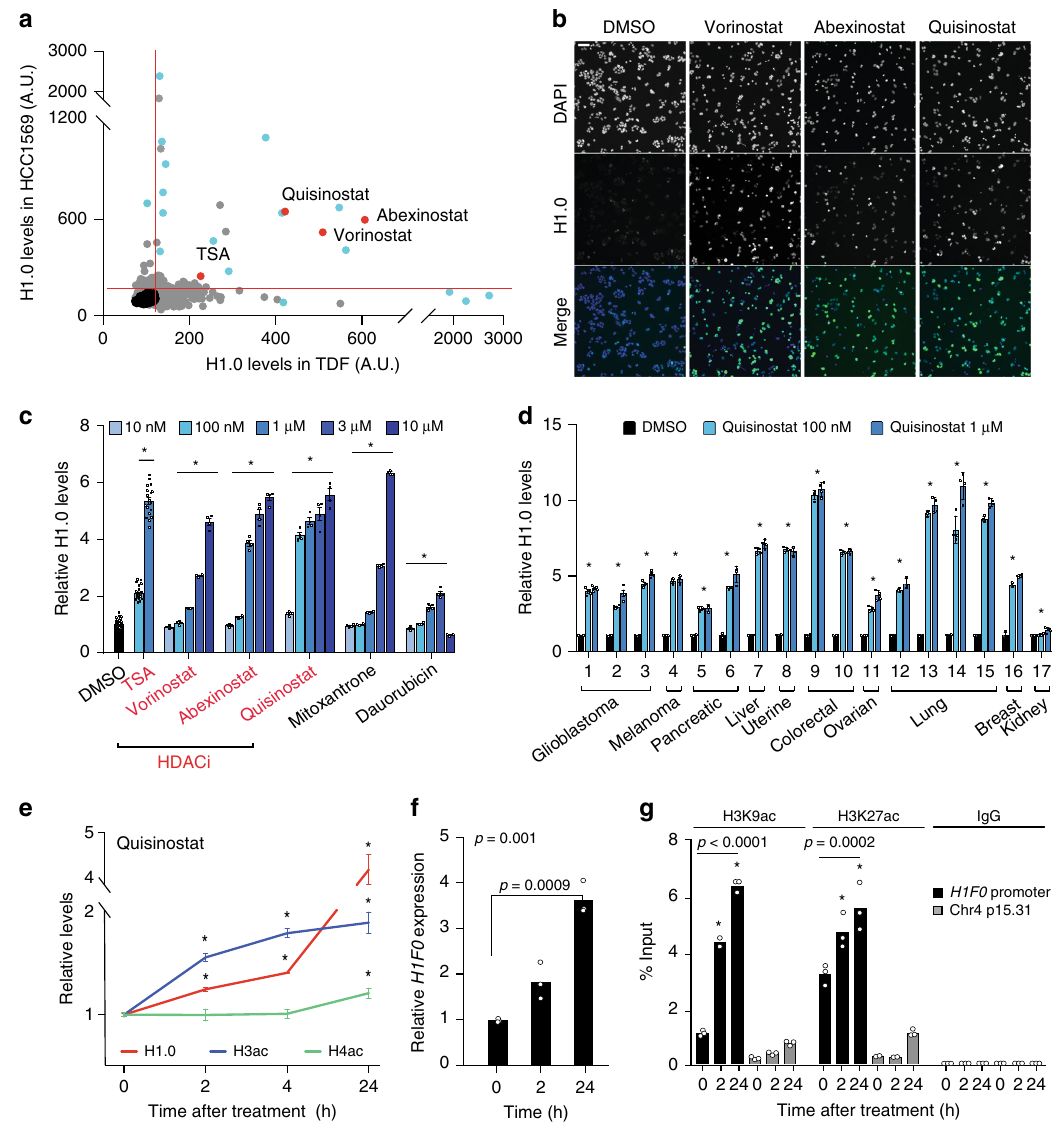
Fig. 1 HDAC inhibitors restore high levels of H1.0 in a large panel of cancer cell lines. a Immuno fl uorescence microscopy quantifying H1.0 levels in the screen. Each dot represents the median value for each compound ( n = 3 biological replicates). Black: DMSO, blue: compounds tested for validation, red: HDACi. b Representative images from one of three HCC1569 biological replicates from the screen. Scale bar: 50 µ m. c Validation experiments in HCC1569 cells. Values represent mean ± s.e.m. from four biological replicates for each condition, except DMSO ( n = 48), 100 nM TSA ( n = 24) and 1 μ M TSA ( n = 18). * p -value < 0.0001 (one-way ANOVA) for each drug titration compared to DMSO. d Immuno fl uorescence microscopy quantifying H1.0 levels 24 h after Quisinostat treatment in cell lines from the indicated cancer types (cell line names listed in Supplementary Table 1). Values represent mean ± s.e.m. from four biological replicates. * p -value < 0.0001 (one-way ANOVA) comparing DMSO- and Quisinostat-treated cells. e Immuno fl uorescence microscopy quantifying levels of H1.0, acetylated H3 (H3ac) and acetylated H4 (H4ac) at the indicated times after 100 nM Quisinostat treatment of HCC1569 cells. Values represent mean ± s.e.m. from eight (H1.0) or four (H3, H4) biological replicates. * p -value < 0.01, compared to 0 h (one-tailed Student ’ s t